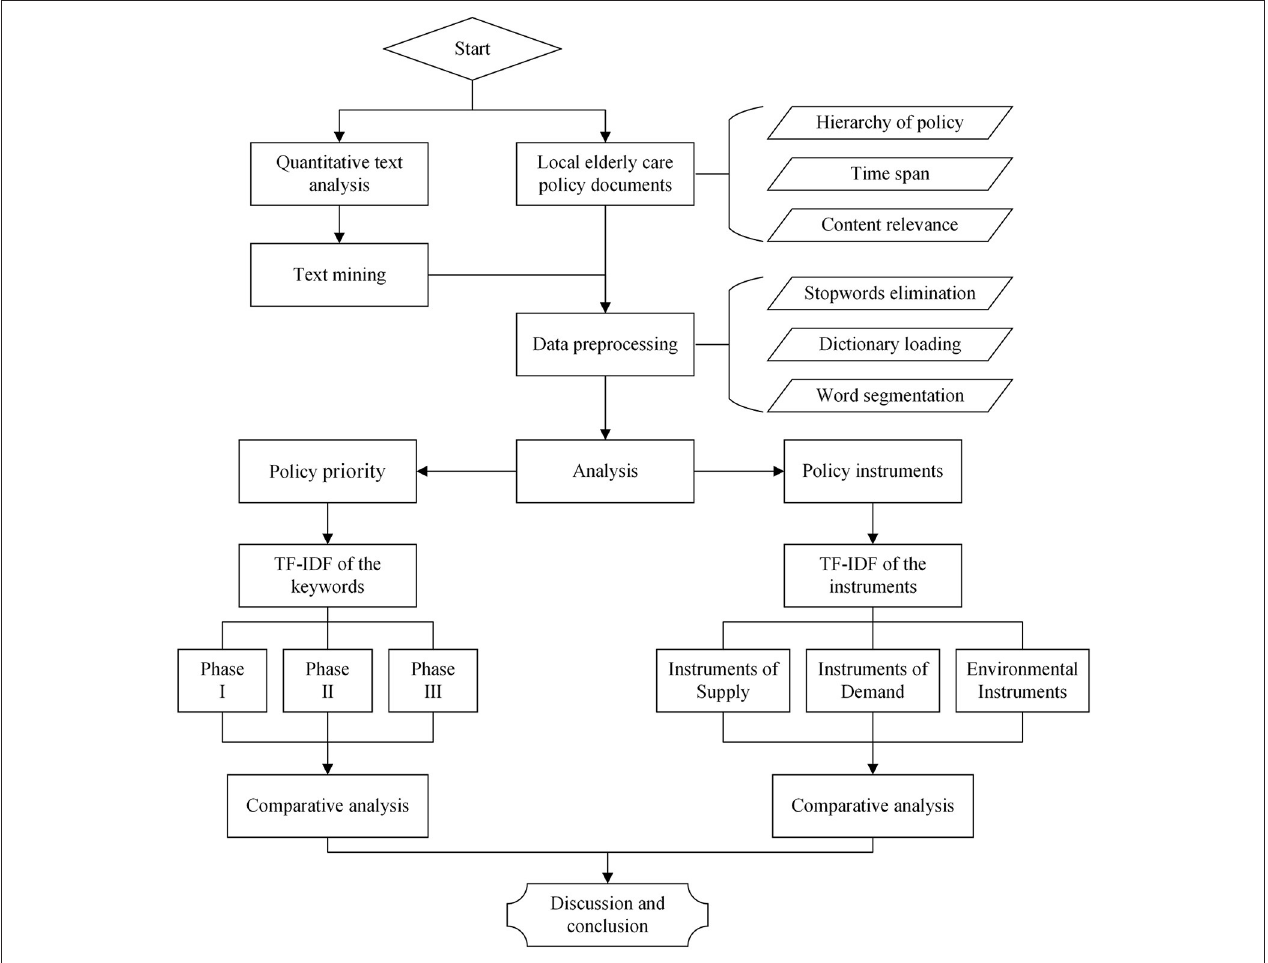
FIGURE 1 | Analysis framework of China’s local elderly care